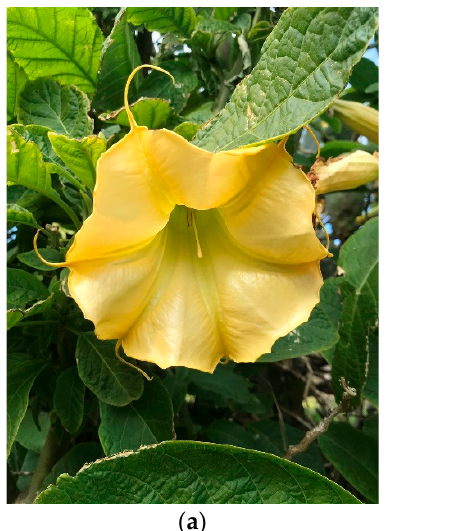
Figure A1. Two different cultivars of Narcissus cv. collected in the Reggio Calabria province. ( a ) Narcissus ‘Cotinga’ in Piani di Reggio, in grazing-meadow (Photograph VLA Laface); ( b ) Narcissus ‘Erlicheer’ in Pellaro, in a roadside along a wall (Photograph CM Musarella). Plants 2020 , 8 , x FOR PEER REVIEW